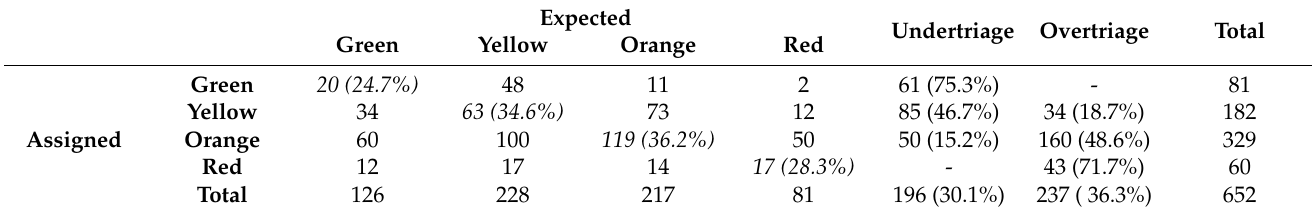
Table A2. Comparison of the triage code originally assigned by local personnel and the code retrospectively obtained by researchers for obstetric/gynaecological cases. The results in italics represent the number of correct triages performed by local personnel; those above and below them identify the percentage of over- and undertriage per category, respectively.